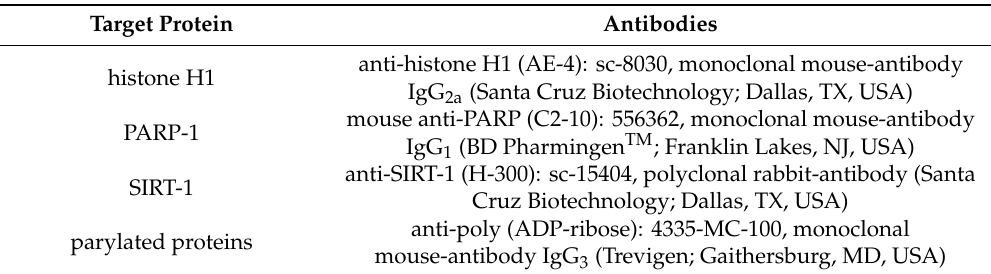
Table A2. Antibodies used in the experiments.